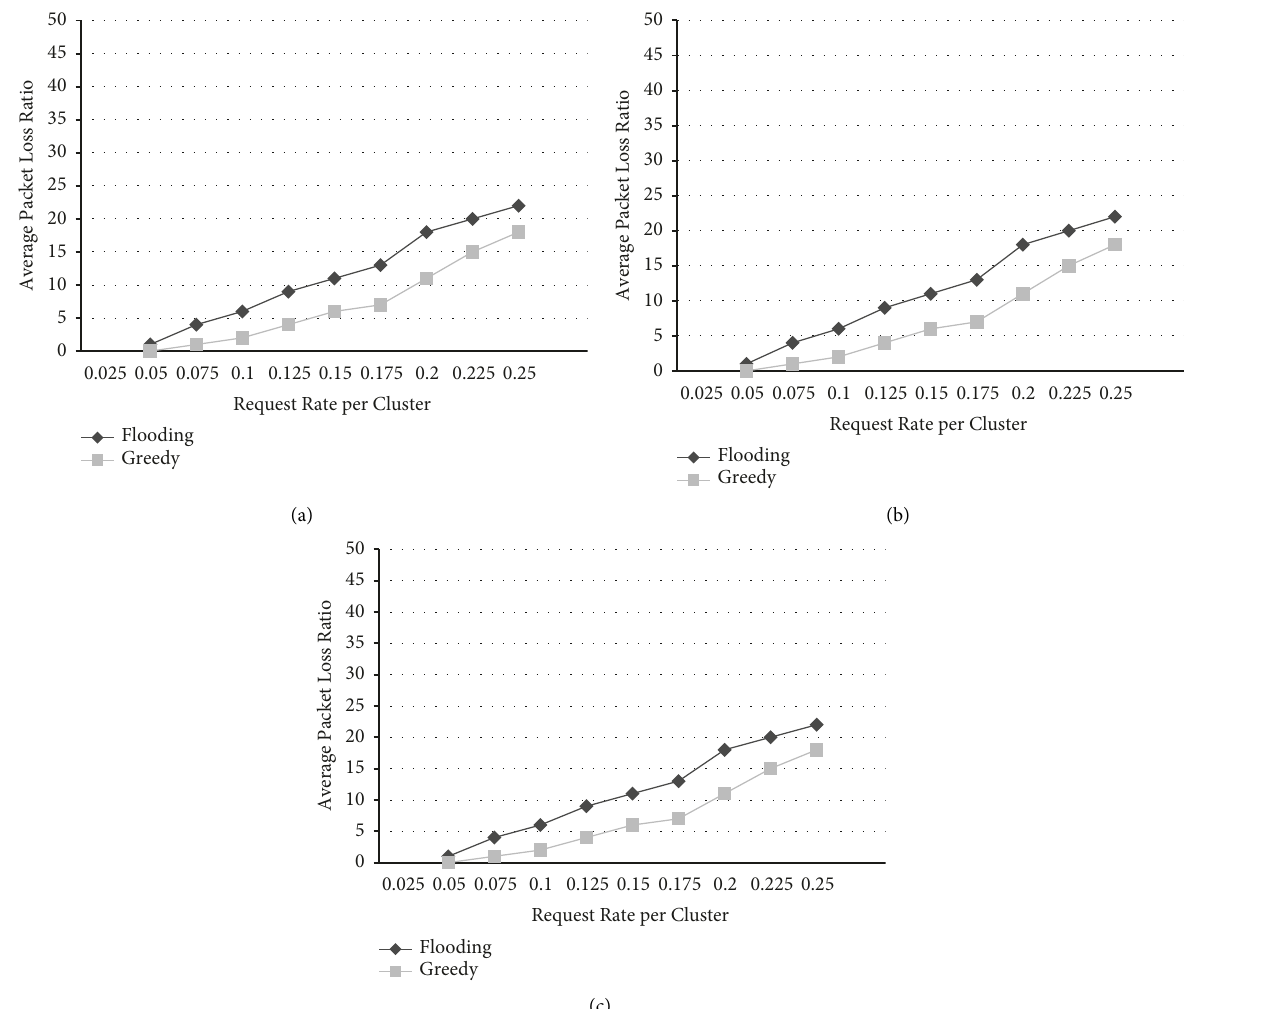
Figure 20: (a) Packet loss ratio in each nanocluster when an average number of nanonodes per nanoclusters are 50. (b) Packet loss ratio in each nanocluster when an average number of nanonodes per nanoclusters are 100. (c) Packet loss ratio in each nanocluster when an average number of nanonodes per nanoclusters are